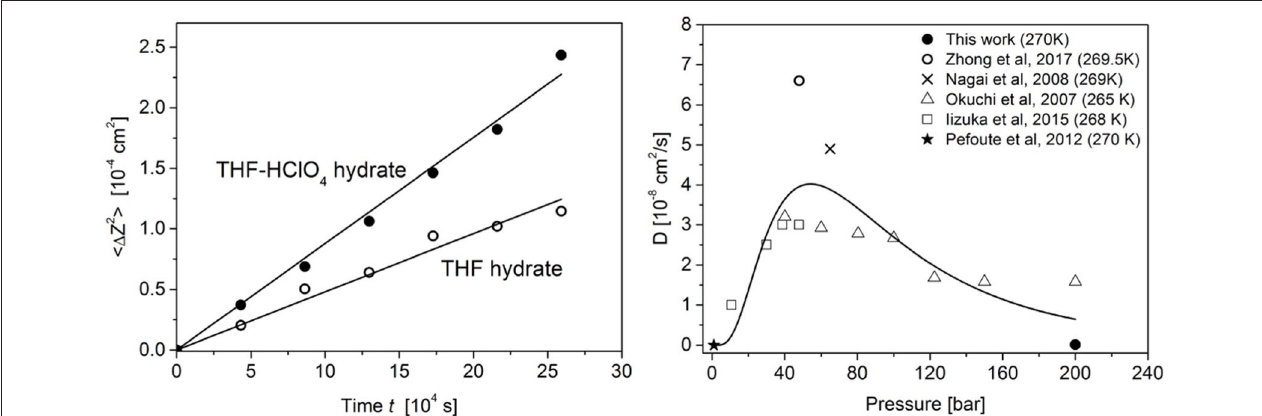
FIGURE 4 | Left : H 2 diffusion length of the THF-HClO 4 -H 2 (filled symbols) and THF-H 2 (open symbols) hydrates measured at 270K and 200 bar. The lines represent the fitted Fick model (see text for details). Right : Pressure dependence of the H 2 diffusion coefficient integrating data from various experimental investigations in the 265–270K region (Okuchi et al., 2007; Nagai et al., 2008; Pefoute et al., 2012; Iizuka et al., 2015; Zhong et al., 2017). The line represents a guide-to-the-eyes showing that the diffusion coefficient goes through a maximum at ca. 55